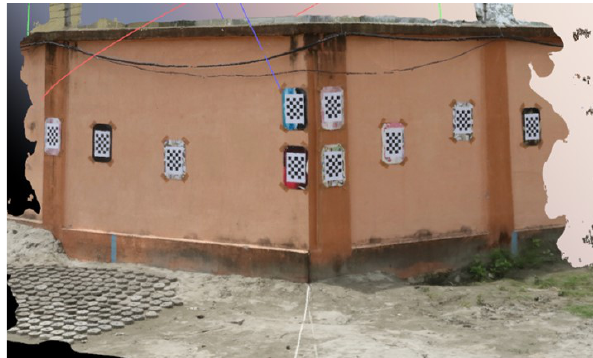
Figure 8: 3D mesh model of 55° corner